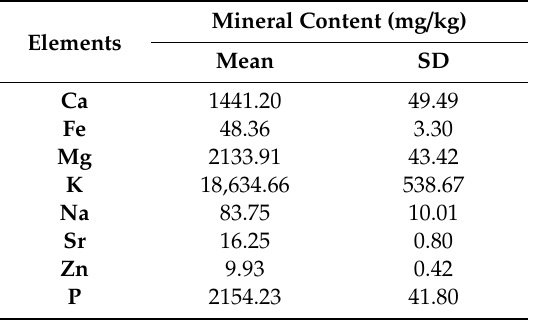
Table 2. Mineral composition of co ff ee